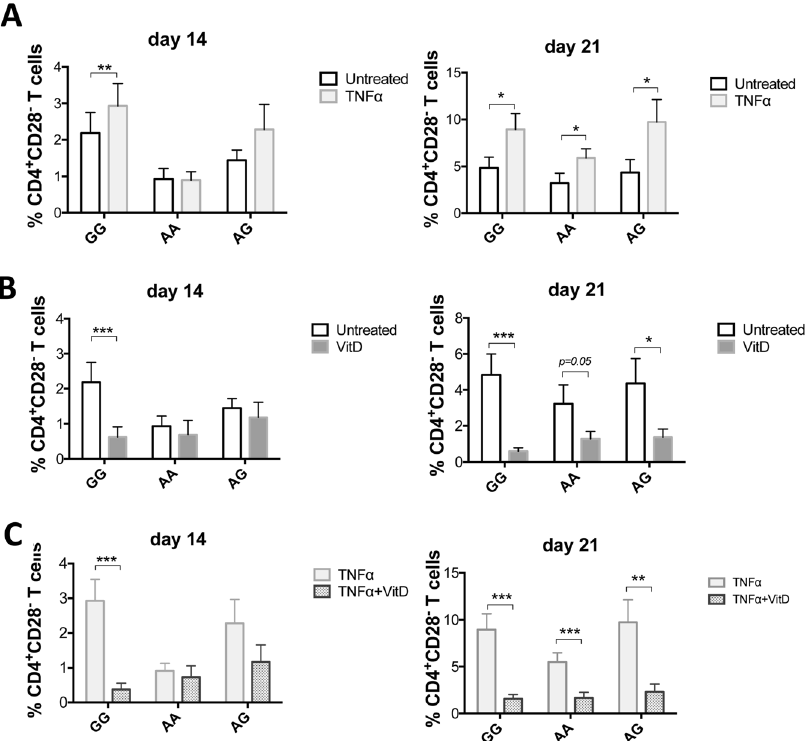
Figure 3. Individuals with AA and AG genotypes are less susceptible to TNF α -mediated loss of CD28 expression. CD4 + CD25 − T cells were activated with aCD3/aCD28 beads (two cycles of activation) in the presence or absence of TNF α and in the presence or absence of 1,25(OH) 2 D 3 for 14 and 21 days. ( A and B ) Data show the proportion of CD4 + CD25 − T cells that lost CD28 expression in the presence (TNF α ) and absence of TNF α (Untreated) and in the presence or absence of 1,25(OH) 2 D 3 after 14 and 21 days. ( C ) Data show the proportion of CD4 + CD25 − T cells that lost CD28 expression in the presence of TNF α and in the simultaneous presence of TNF α and 1,25(OH) 2 D 3 after 14 and 21 days in culture. Healthy individuals homozygous (AA) (n = 14) or heterozygous (AG) (n = 14) for the PSC risk SNP “rs7426056” in the CD28 locus and n = 14 homozygous for the protective allele (GG). Data show mean with SEM. * p < 0.05, ** p < 0.01, *** p < 0.001 with Wilcoxon matched-pairs signed rank